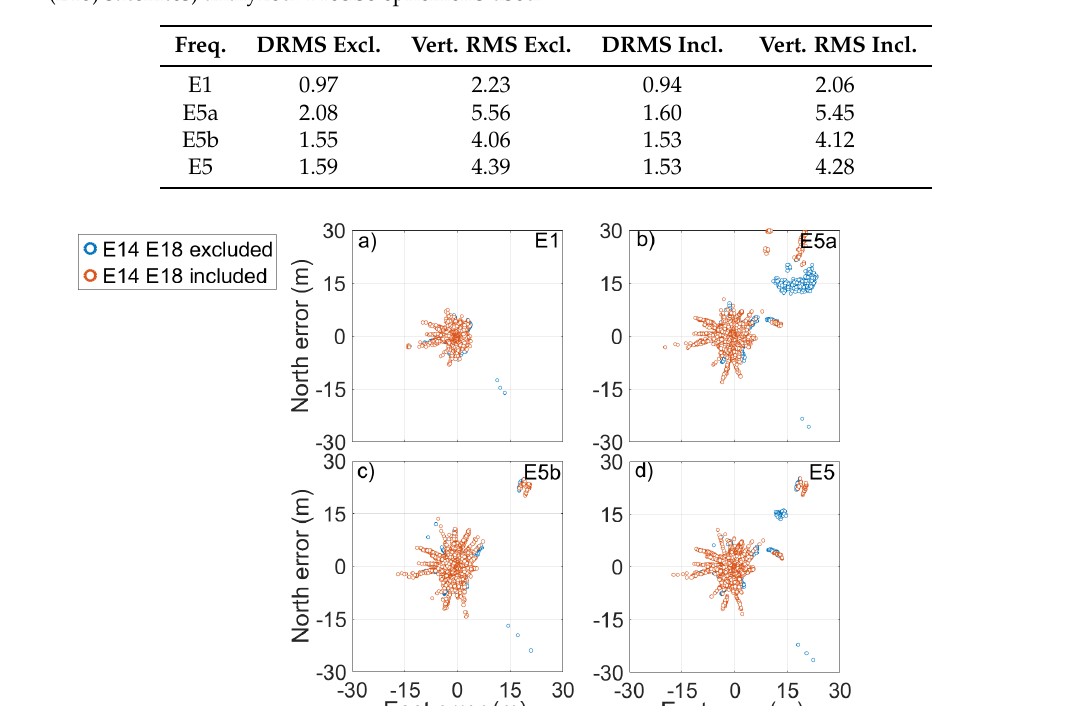
Table 3. RMS comparison between two scenarios (including or excluding the Milena (E14) and Doresa (E18) satellites) analyzed. Precise ephemeris used.